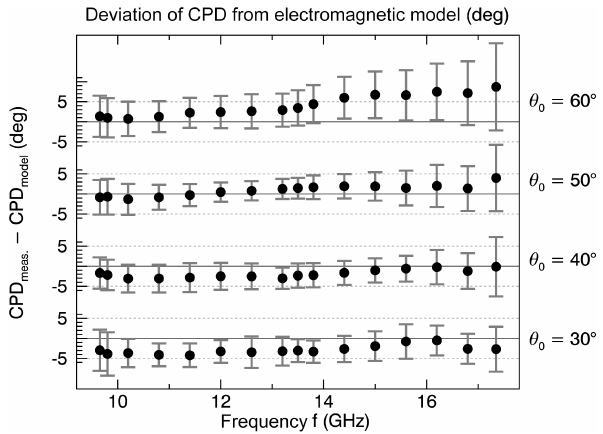
Figure 13. Deviation of measured and modeled CPD for differ- ent frequencies f and different incidence angles θ 0 . Dots show the mean deviation CPD meas. − CPD modeled of all data acquired during dry snow conditions. The error bars are the standard deviations cal- culated from about 5600 measurements acquired at different times.